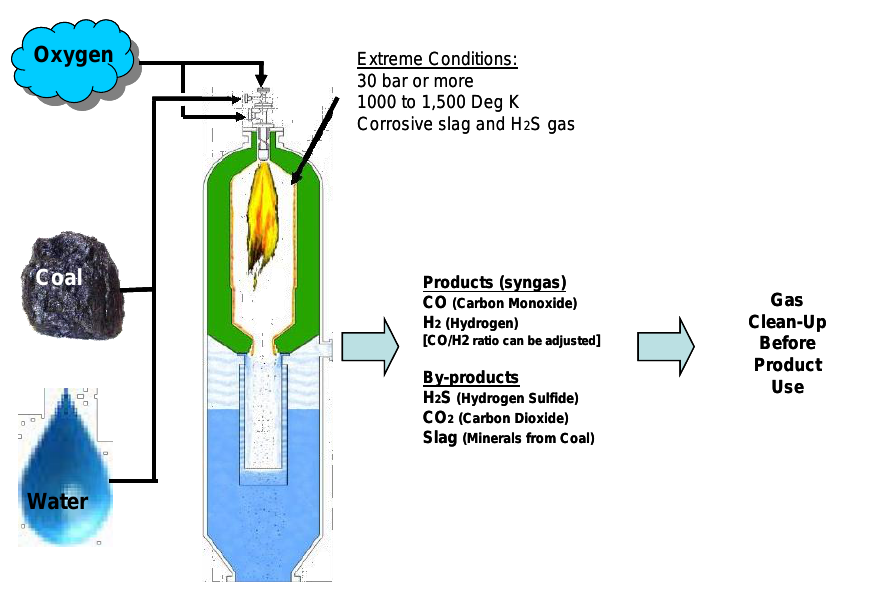
Figure 1. Gasification process